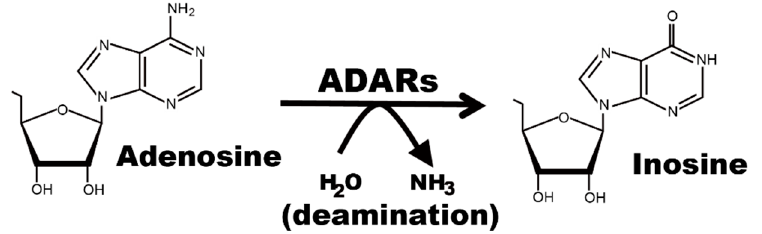
Figure 1. Adenosine-to-inosine RNA editing. Adenosine deaminases acting on RNA (ADARs) convert adenosine into inosine through a deamination reaction.